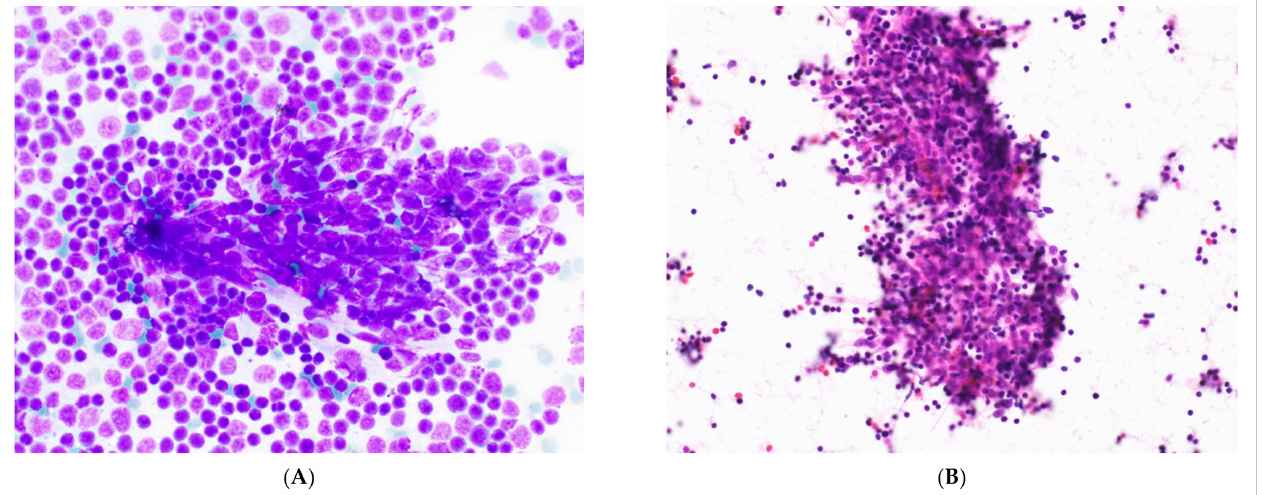
Figure 6. Type B thymoma mimicking a lymphoid lesion. ( A ) Epithelial cell clusters may be obscured by streaking crushed lymphocytes mimicking a lymphoid tangle. Romanowsky stain, 60 × objective. ( B ) Epithelial cells may be detected in other regions of the smear but can still be challenging to type. H&E stain, 40 × objective.